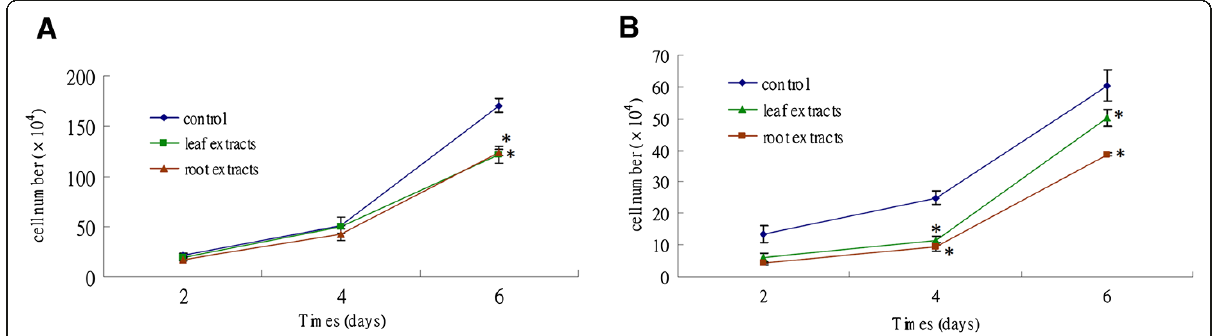
Figure 2 Effect of P. indica leaf or root crude aqueous extract on the growth of cancer cells. Growth curves of ( A ) GBM8401 cells and ( B ) HeLa cells after 300 μ g/ml P. indica leaf or root aqueous extract treatment. Each experiment was done in triplicate. Data are expressed as mean ± SD. * P < 0.05.